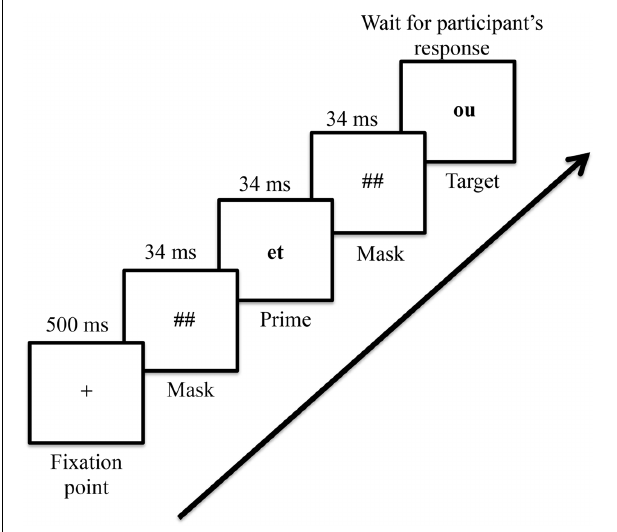
FIGURE 1 | Time course for a single trial. Each trial started with a fixation point in the middle of the screen presented during 500 ms. Then a mask, a prime and a mask appeared for 34 ms each, immediately followed by the target word that appeared in the screen until the participant answered if it was a word or a pseudo-word. Note that for each trial, the mask contained exactly the same numbers of characters of the word used as prime.